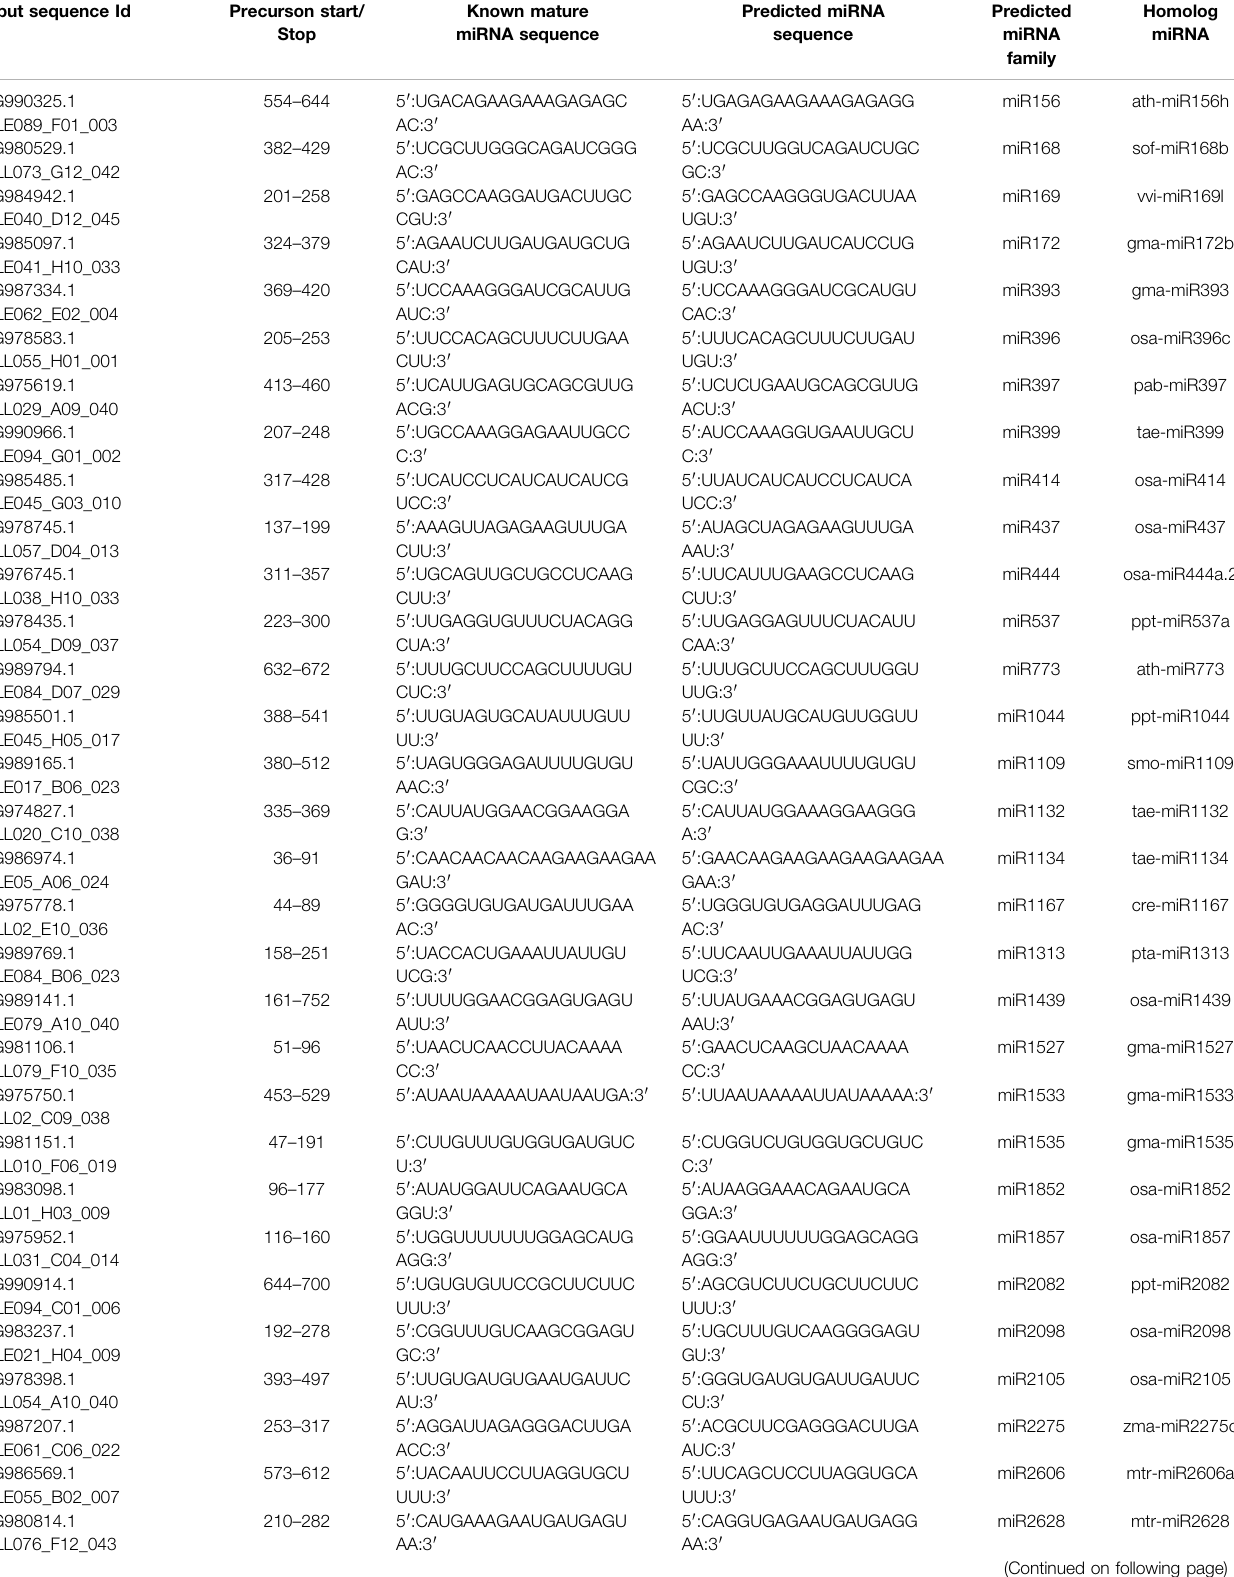
TABLE 4 | List of predicted miRNA families in cluster